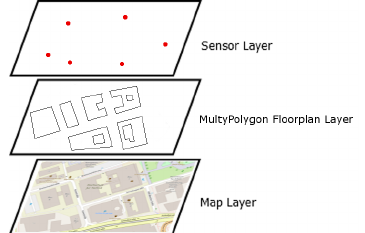
Figure 2. An illustration of a 2D visualization. Base Map c (cid:13) OpenStreetMap